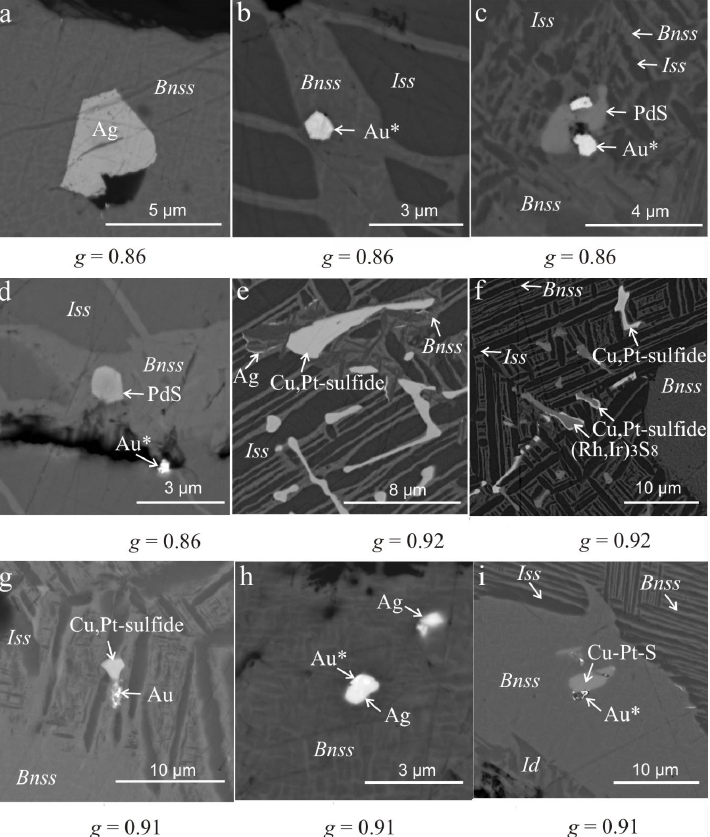
Figure 6. SEM images ( a – i ) of Au, Ag, Pt, Pd, and Rh phases microstructures in sulfide matrices in back-scattered electrons. Palladium forms the phase Pd 0.97 Cu 0.04 S, which is similar to the vysotskite mineral but contains an admixture of Cu. It is present in bornite as faceted crystals about 1 × 1 µm in size in the Bnss matrix (Figure 6d), but more often, its grains form intergrowths of Pd 0.97 Cu 0.04 S/Au* in the matrix Iss + Bnss (Figure 6c). In [55], it was shown that up to 1 at. % Cu can be dissolved in PdS. The Au* alloy contains ~84 at. % Au, ~13 at. % Ag, and several percentages of Cu and Fe. The main part of Au* inclusions, its two-phase inter- growths with Ag, PdS, and Cu-Pt-sulfide phase are related to Bnss (Figure 6b – d,g – i). Sil- ver with an impurity of ~2 at. % Cu that were single-phase faceted inclusions up to 4 × 4 µm in size and two-phase aggregates Ag/Au* were found in the Bnss matrix (Figure 6a,h). In addition, Iss grains were turned by Ag (Figure 6f). The presence of impurities in Au*and